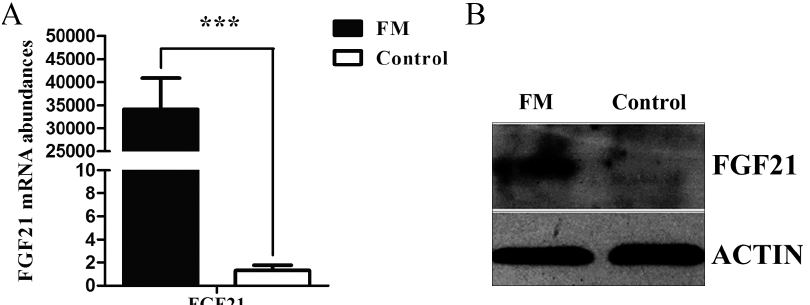
Figure 3. FGF21 expression in the FGF21 stable monoclone (FM) cells before cell differentiation. ( A ) qRT-PCR analysis revealed that FM cells had higher FGF21 mRNA level than that in the control; and ( B ) Western blot analysis showed that the FGF21 protein level was up-regulated significantly in FM cells. Gene expression was normalized to GAPDH . Data was presented as mean ± SD, *** for p < 0.001.